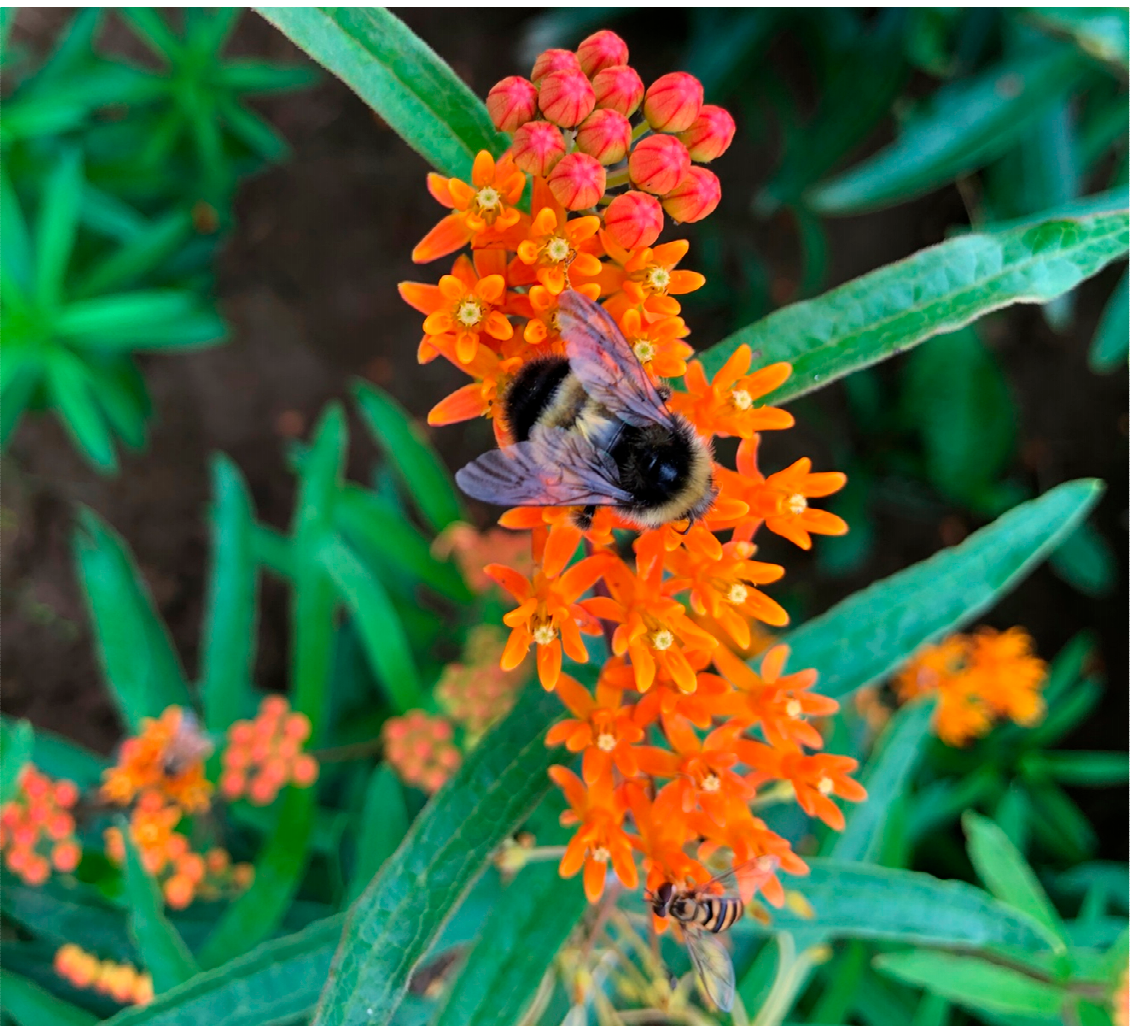
Figure 2. Bombus terricola gyne foraging on butterfly weed, Asclepias tuberosa L., in a wild flower pollinator reservoir approximately 13 m from the presumed colony nest in the tractor.